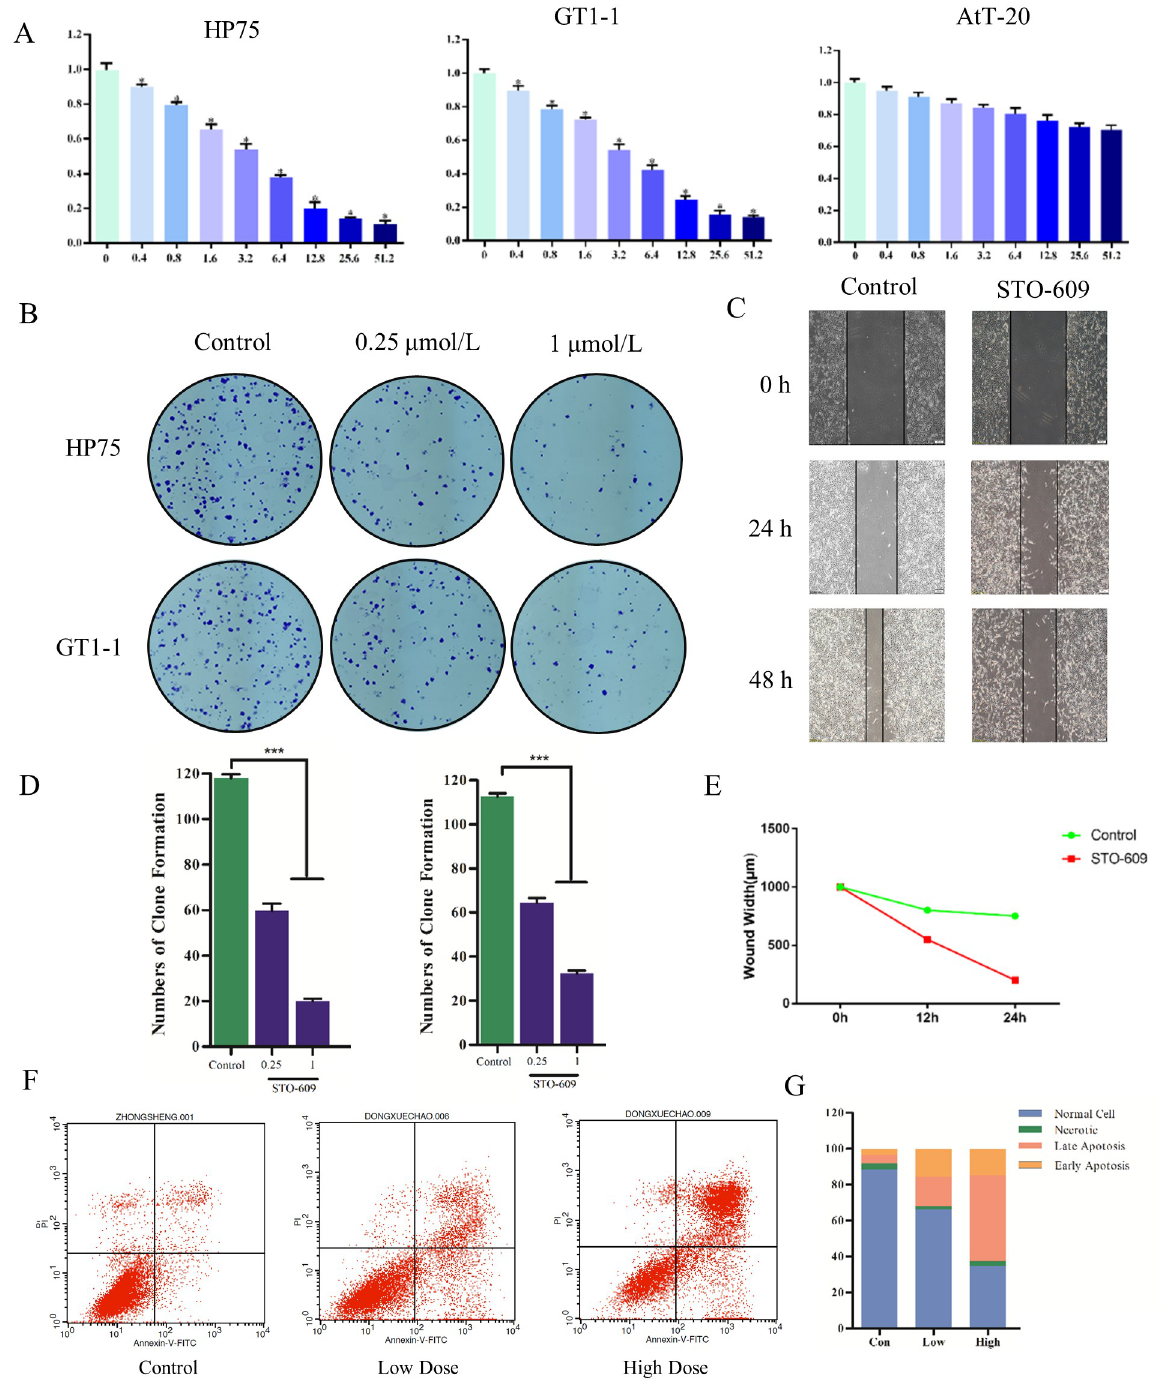
Fig 4. (A) Cellular viability of HP75, GT1-1 and AtT-20 cells treated with STO-609 (B) Clonogenicities in Petri dishes with different doses of STO-609 (C) Scratch assay in control and STO-609 group (D) numbers of clone formation in HP75 cell line and GT1-1 cell line (E) Wound width in control and STO-609 (F) The distribution of cells in apoptosis with different doses of STO-609 (G) The percentage of apoptosis cell treated with different dose of STO-609.